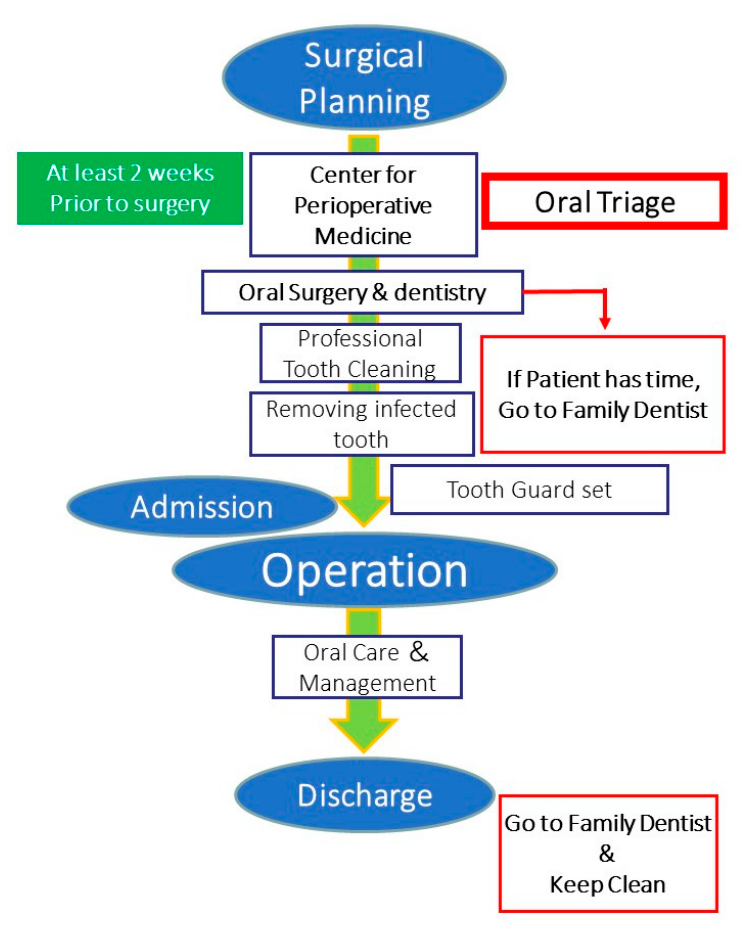
Figure 2. Unique “oral triage” system for Perioperative Oral Management. The patient is required to visit the perioperative center at least two weeks prior to the surgical procedure to assess and evaluate the oral and medical conditions (including the drug history) in order to avoid any complications during general